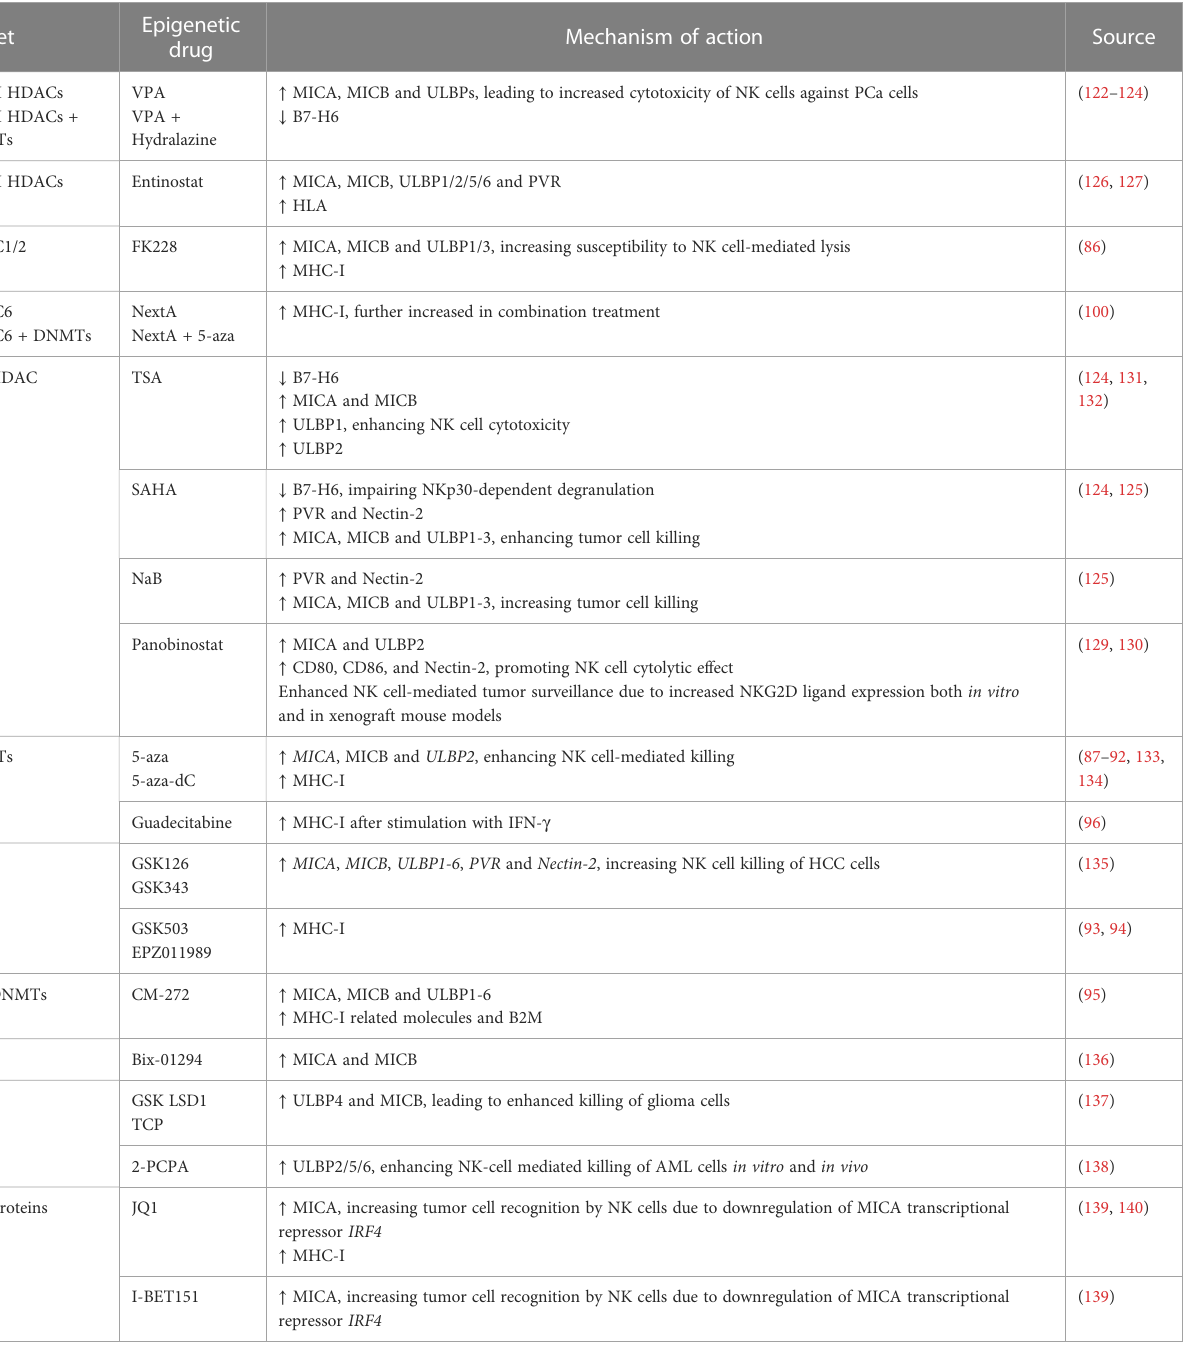
TABLE 2 Epigenetic modulating agents and their effect on NK cell